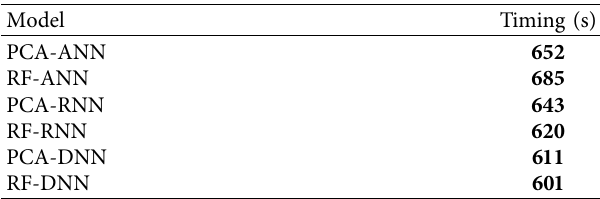
Table 7: Validated analysis of the proposed model for computa- tional timing analysis in Google Colab with 50 features.